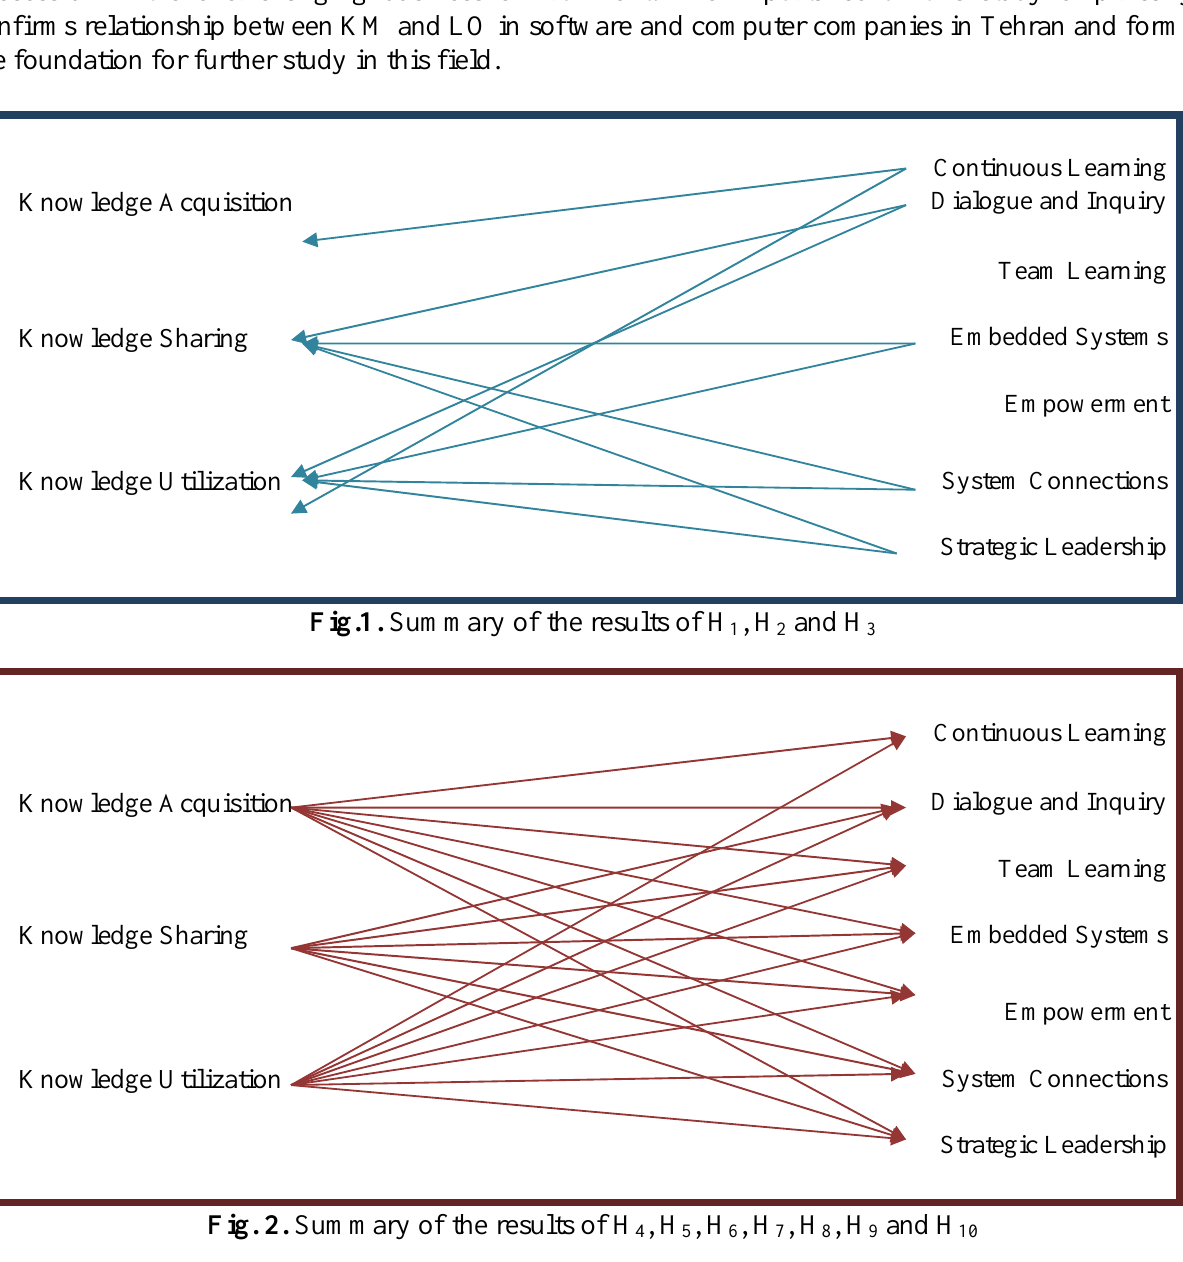
Fig. 2. Summary of the results of H